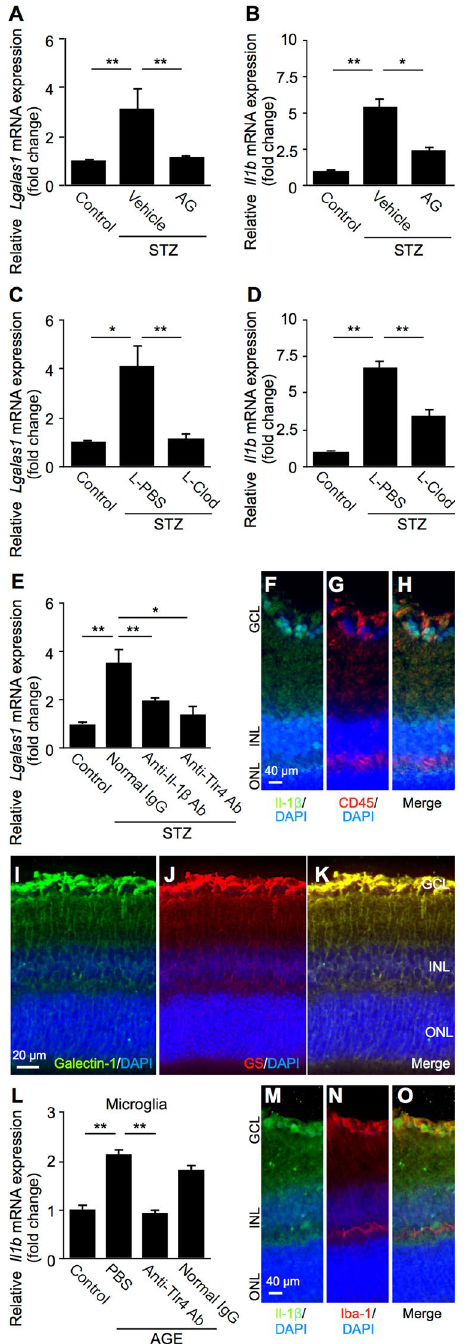
Figure 6. Diabetes-induced expression of retinal Lgals1 via AGE-triggered inflammatory cues. ( A , B ) Retinal Lgals1 and Il1b expression in mice with STZ-induced diabetes at 2 months. STZ mice received aminoguanidine (AG) for 7 consecutive weeks, and processed for gene expression. ( C , D ) Diabetic mice were given an intraperitoneal injection of 1-mg clodronate liposomes (L-Clod) 72 hours before Lgals1 and Il1b gene expression analysis. Liposomes containing PBS were used as a vehicle control (L-PBS). ( E ) Neutralization antibodies against Il-1 β (2.5 μ g/eye) and Tlr4 (1.0 μ g/eye) were injected intravitreally to STZ mice, in comparison with normal IgG (2.5 μ g/eye), 48 hours before Lgals1 gene expression analysis. (n = 4–6 per group). ( F–H ) Double labeling of Il-1 β ( green ), CD45 ( red ) and DAPI ( blue ) in the retina of mice with STZ-induced diabetes at 2 months. Scale bar = 40 μ m. ( I–K ) Double labeling of galectin-1 ( green ), GS ( red ) and DAPI ( blue ) in the diabetic retina. Scale bar = 20 μ m. ( L ) Murine primary microglia was pretreated with a neutralizing antibody against Tlr4 (10 μ g/ml), in comparison with PBS or control normal IgG (10 μ g/ml) for 30 minutes followed by treatment with AGE-BSA (50 μ g/ml) for 24 hours, and Il1b gene expression levels were analyzed. * p < 0.05, ** p < 0.01 (n = 6 per group). ( M–O ) Double labeling of Il-1 β ( green ), Iba-1 ( red ) and DAPI ( blue ) in the retina of mice with STZ-induced diabetes at 2 months. Scale bar = 40 μ